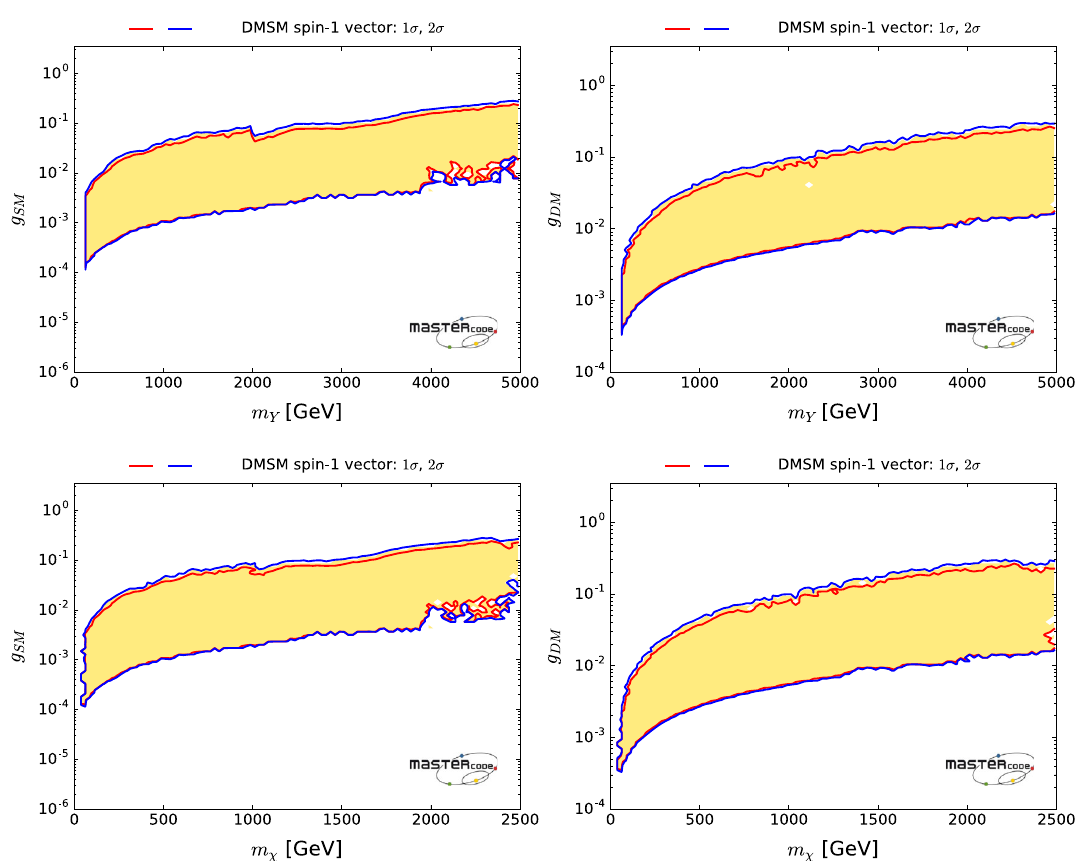
Fig. 14 The likelihood functions for g SM (left panel) and g DM (right panel) as functions of m χ in the model with vector couplings after the selection 1 / 3 < g SM / g DM < 3. We again use colour coding to illustrate the dominant mechanisms bringing the DM density into the